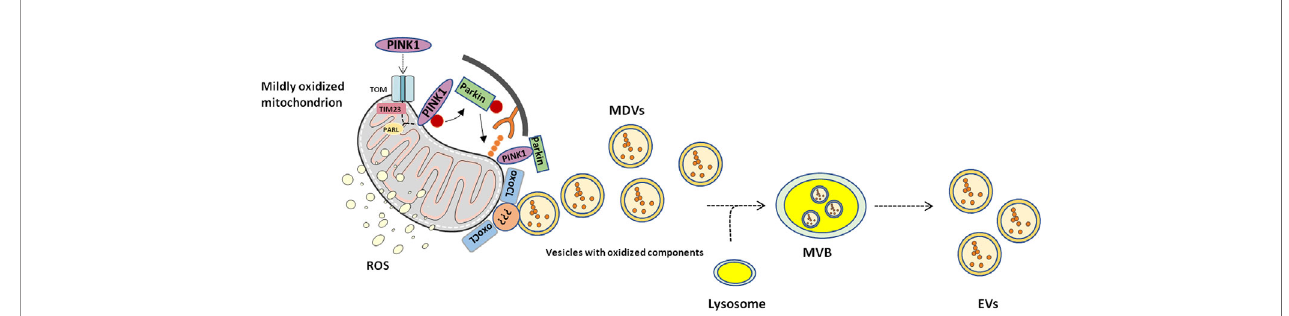
FIGURE 2 | Proposed mechanism of mitochondrial-derived vesicle generation and release. Mitochondrial-derived vesicles (MDVs) may represent an additional level of mitochondrial quality control through which mildly damaged mitochondria are targeted and displaced. Phosphatase and tensin homolog-induced kinase 1 (PINK1) and Parkin prime damaged mitochondria for disposal. Membrane curvatures generated by oxidized cardiolipin (oxoCL) and other unknown proteins allow generation of MDVs that form multivesicular bodies (MVBs) within the endolysosomal system. Eventually, MVBs are extruded from the cell as extracellular vesicles (EVs). PARL, presenilin-associated rhomboid-like; ROS, reactive oxygen species; TIM23, translocase of inner mitochondrial membrane 23; TOM, translocase of the outer